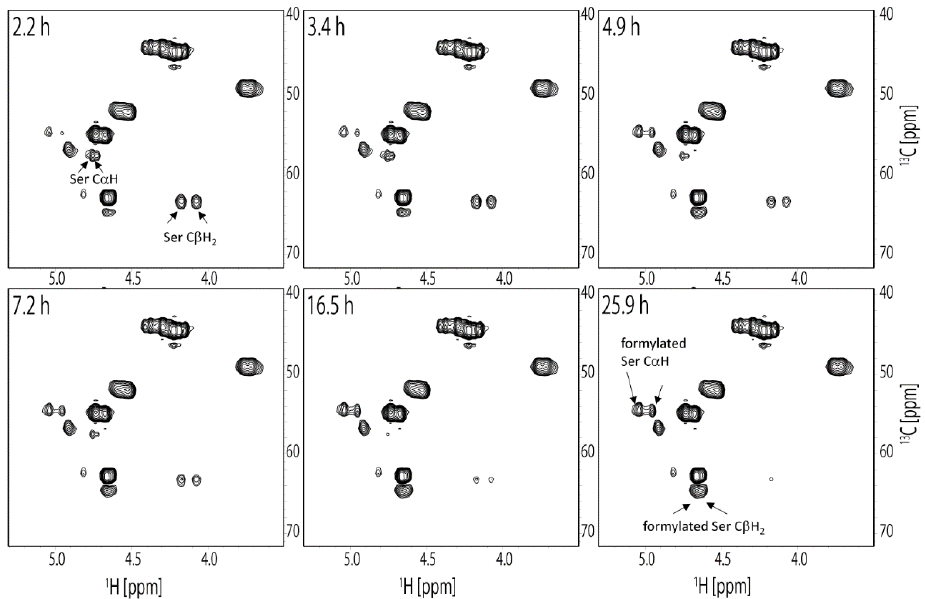
Figure 6. The selected spectra of the time course 13 C HSQC experiments with RSP to observe the formylation in real time after the dissolution of RSP in FA. The elapsed time from start of the measurements is denoted at top left of each box. Peaks derived from unformylated and formylated Ser residues are denoted in the spectra.